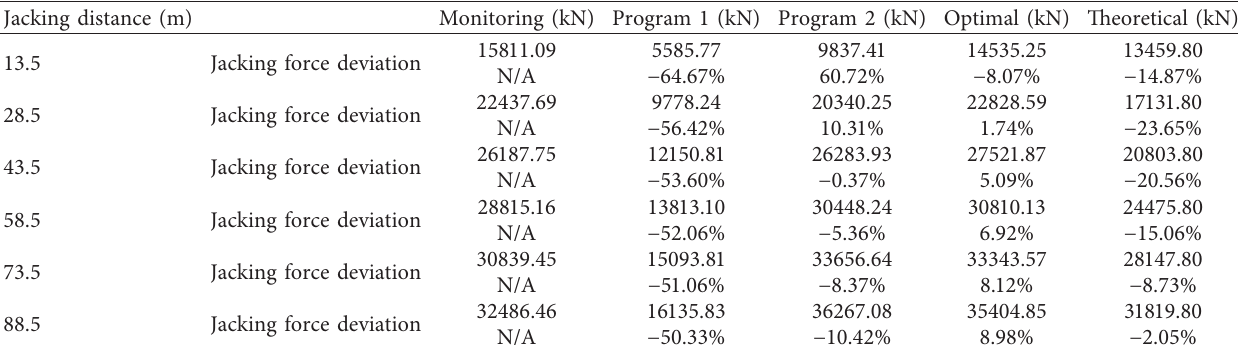
Table 10: Comparison of jacking force estimation deviation for case B1 under different grouting pressure programs. Jacking distance (m)